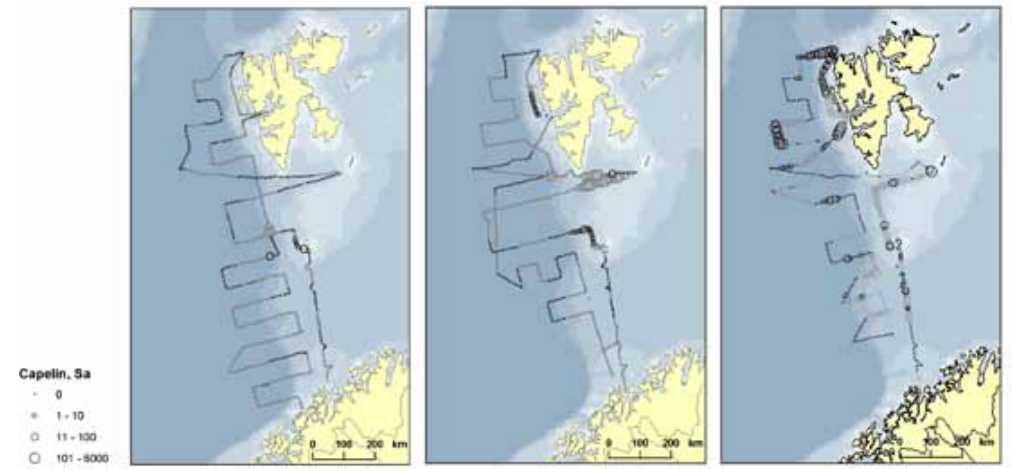
Fig. 6. Distribution of capelin along the cruise lines in 2000, 2001 and 2002. Black cruise line segments indicate segments with observer effort >0 which are included in the statistical analyses of cetacean habitat and prey selection, grey cruise line segments indicate segments with observer effort=0 which are not included in the statistical